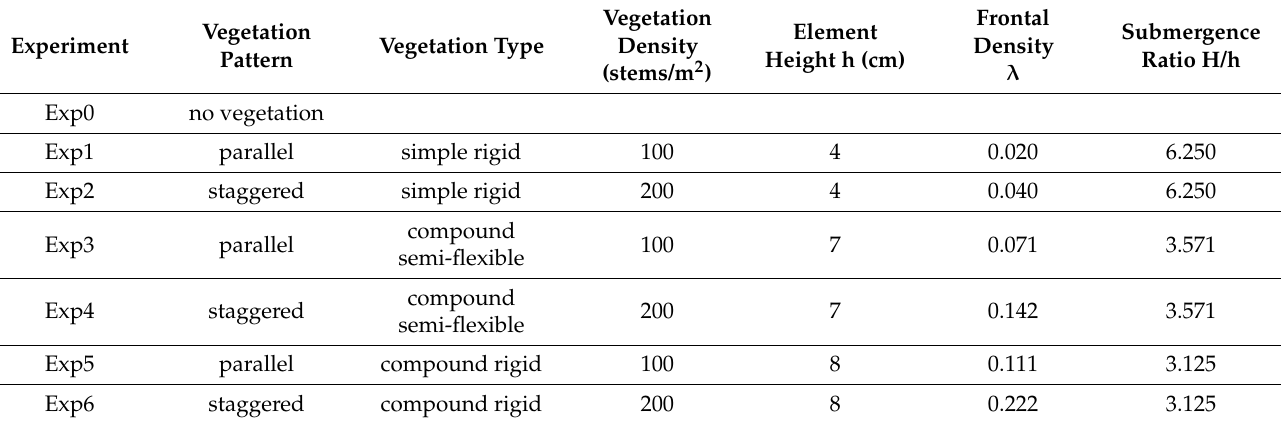
Figure 2. Vegetation elements: ( a ) simple rod, ( b ) compound rigid and ( c ) compound semi-flexible. Table 1. Sets of experiments.